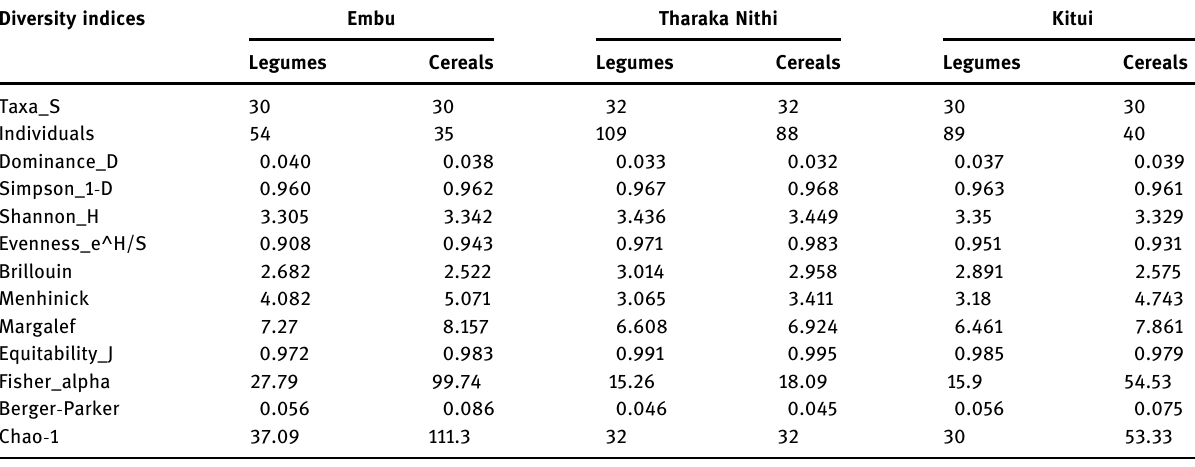
Table 2: Diversity indices of the common cereals and legumes varieties grown in the study area Diversity indices